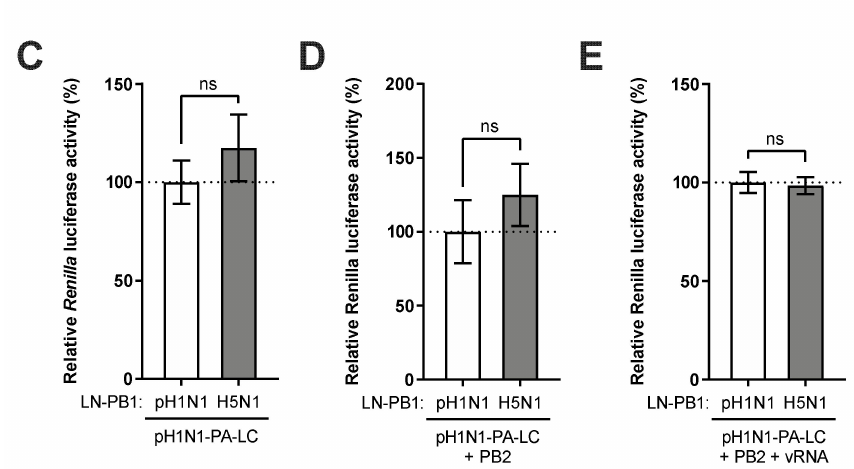
Figure 3. Avian-origin PB1 has a minor e ff ect on viral polymerase complex assembly. ( A ) Schematic diagram of PB1 and PA constructs used in split luciferase complementation assay (SLCA). LN: